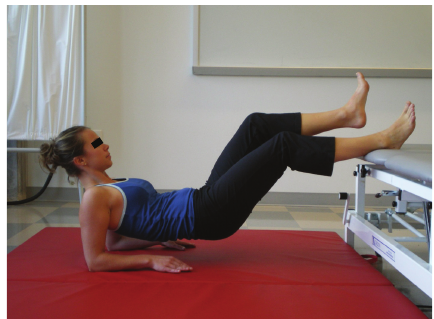
Figure 4: Posterior stabilizing line (PSL).